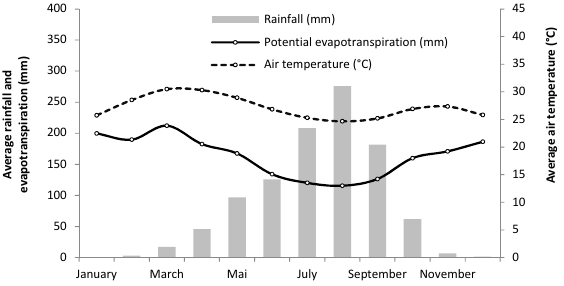
Figure 1. ( a ) Study area location in Burkina Faso; ( b ) Mouhoun and Kou catchments with gauging stations, rainfall stations, and monitoring boreholes used in this study; and ( c ) Nasso-Guinguette springs area.